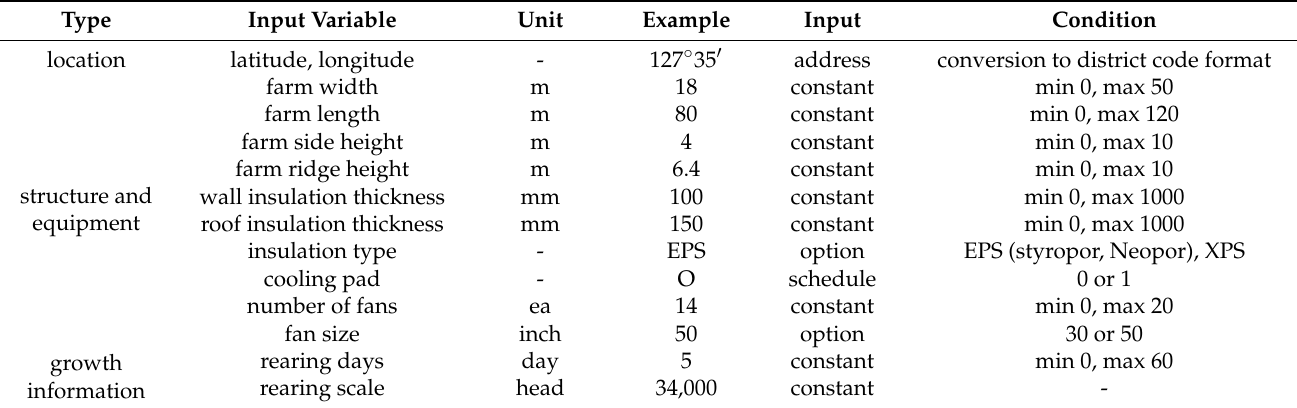
Table 3. Variables the user enters into the